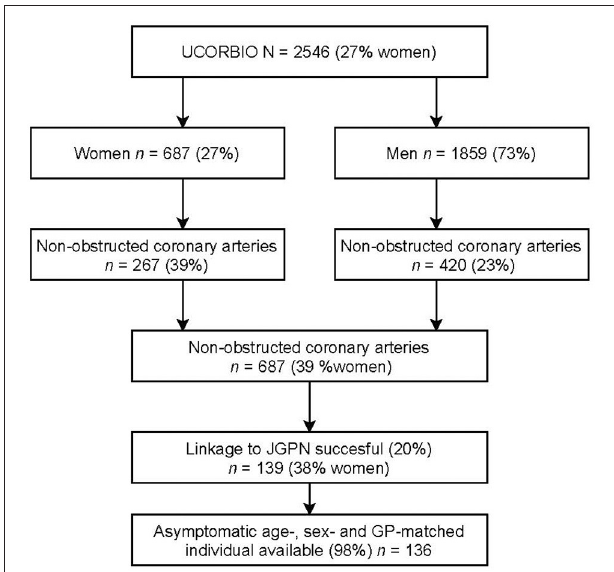
FIGURE 1 | Flowchart of selection of the study